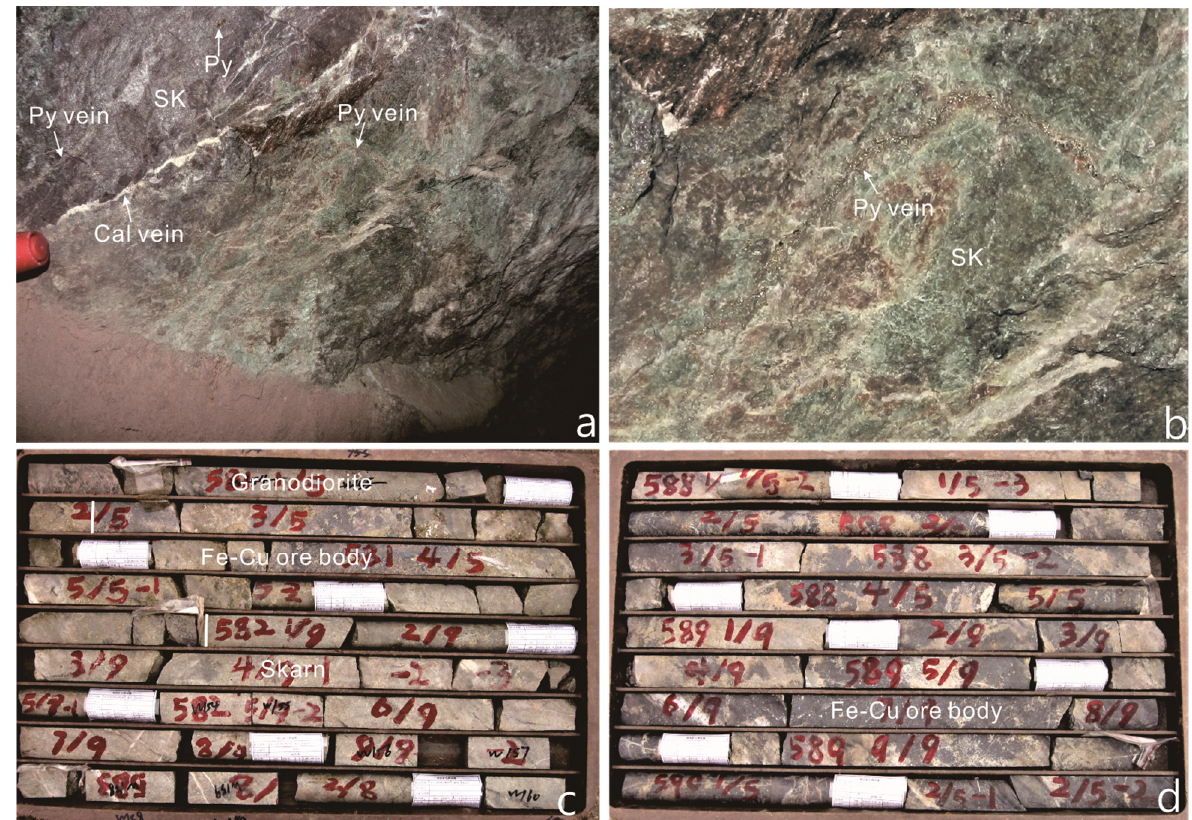
Figure 3. ( a ) Underground photo showing skarns at the contact zone between the No. 3 granodiorite and country rocks; ( b ) The close-up of photo ( a ) showing pyrite veinlets in the skarn. ( c ) Core image showing the Fe-Cu ore body at the contact zone where skarns are present, note the granodiorite rocks in the first row of the core box. ( d ) Core image showing numerous calcite veins (yellow-white color) occur within the Fe-Cu ore body. Abbreviations: Cal—calcite, Py—pyrite, SK—skarn.